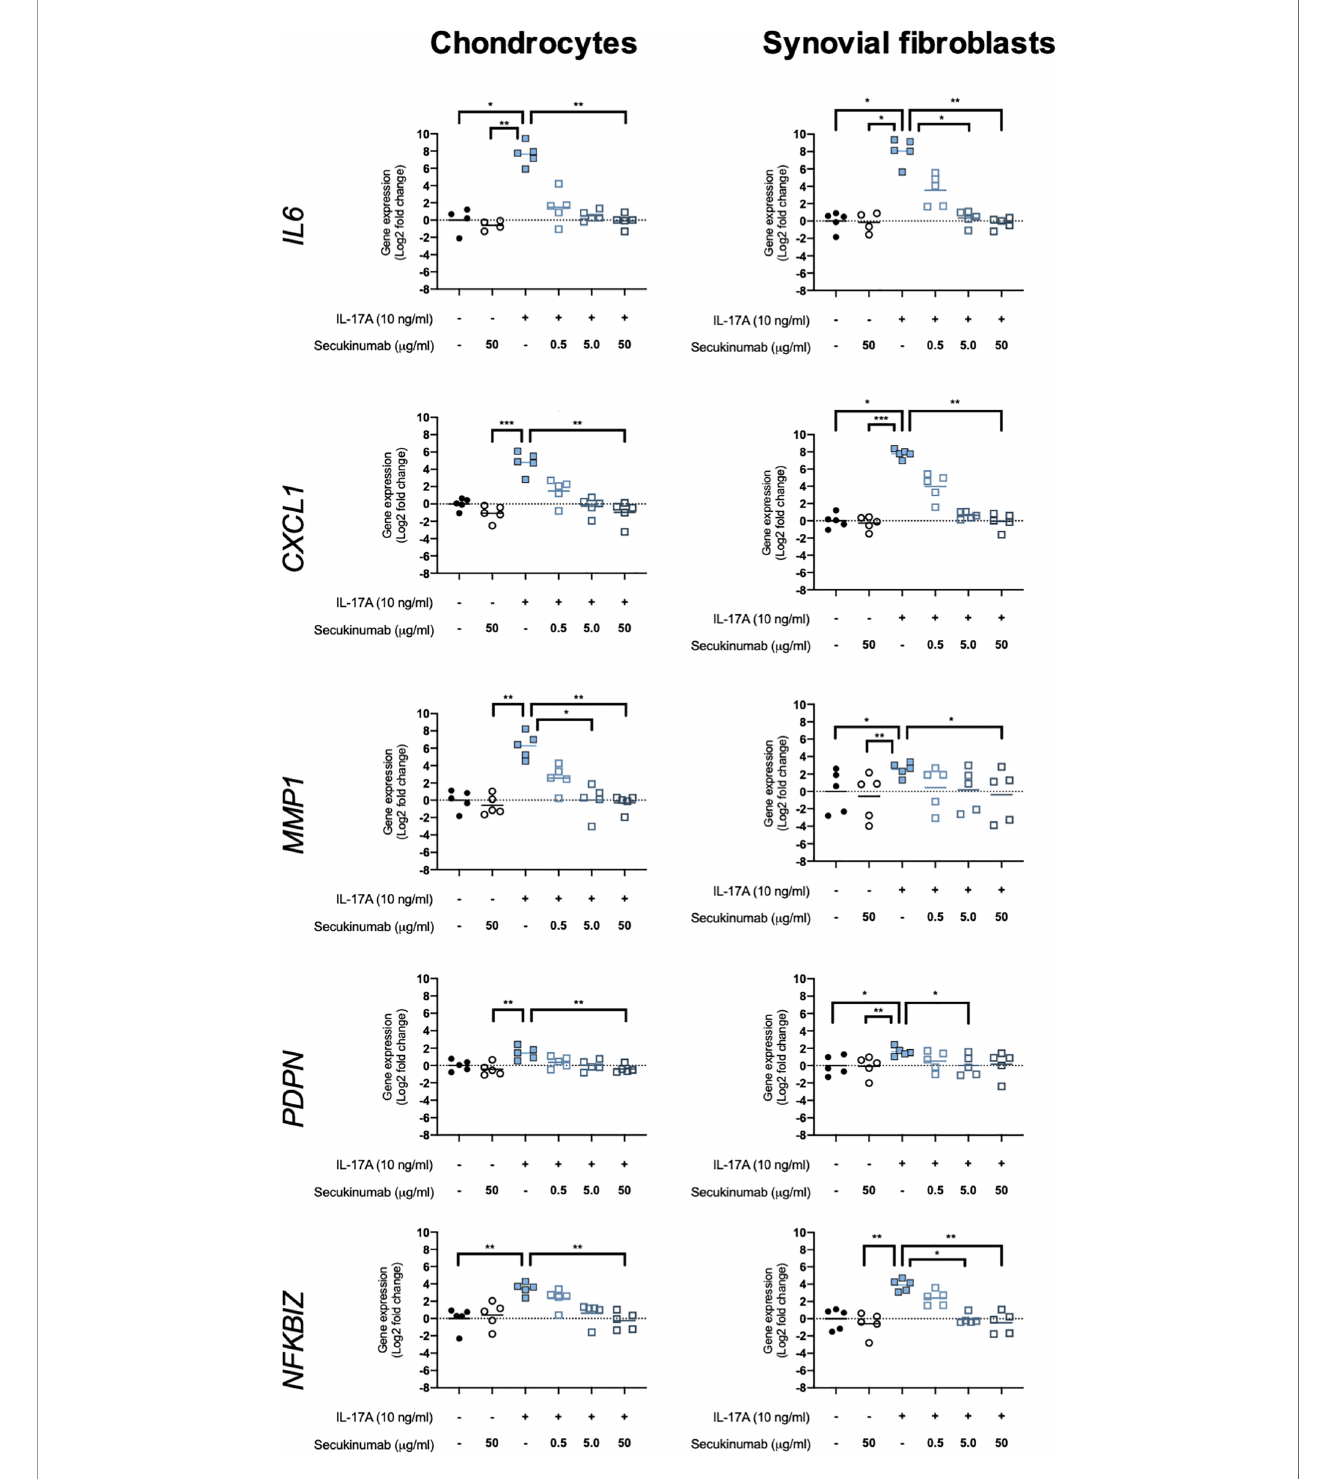
FIGURE 6 | Gene expression of chondrocytes and synovial fi broblasts after treatment with IL-17A (10 ng/ml) with or without clinically-used IL-17A-antibody secukinumab in different concentrations (0.5, 5.0, or 50 m g/ml). Gene expression was calculated using the ddCT-method using both GAPDH and ACTB as housekeepers. Gene expression is expressed as log2 fold change compared to control. Changes in gene expression were calculated comparing each treatment to IL-17A treatment alone. Kruskal-Wallis test with Dunn ’ s multiple comparisons test ( IL6 ). Friedman test with Dunn ’ s multiple comparisons test (all other genes). Individual values and mean. N=5. *p < 0.05, **p < 0.01, ***p <